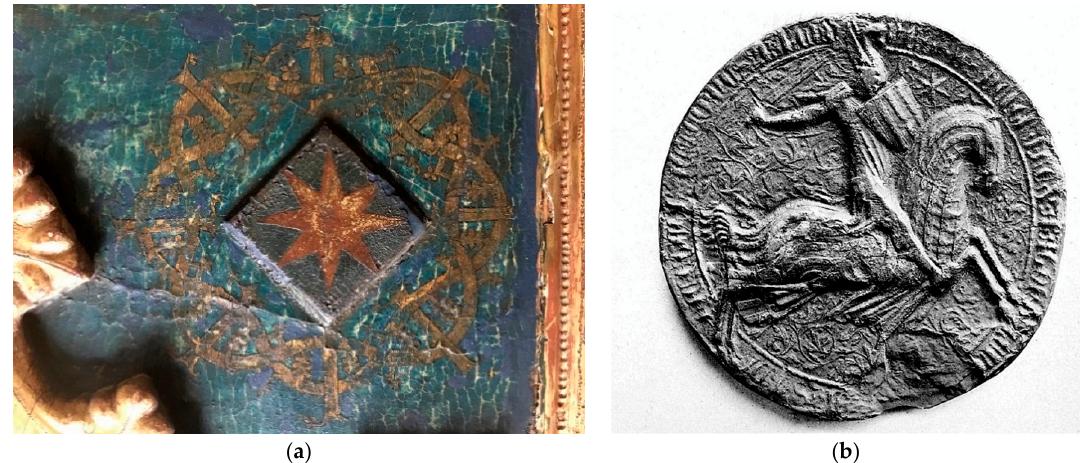
Figure 42. ( a ) Eight-pointed star, Francesc Comes the Younger (?), Triptych with Virgin and Child with St George and St Martin, ca. 1395, upper part. © Used with permission of the Isabella Stewart Gardner Museum, Boston; ( b ) seal of Peter the Ceremonious with the star. Source: (De Sagarra y Siscar 1898).